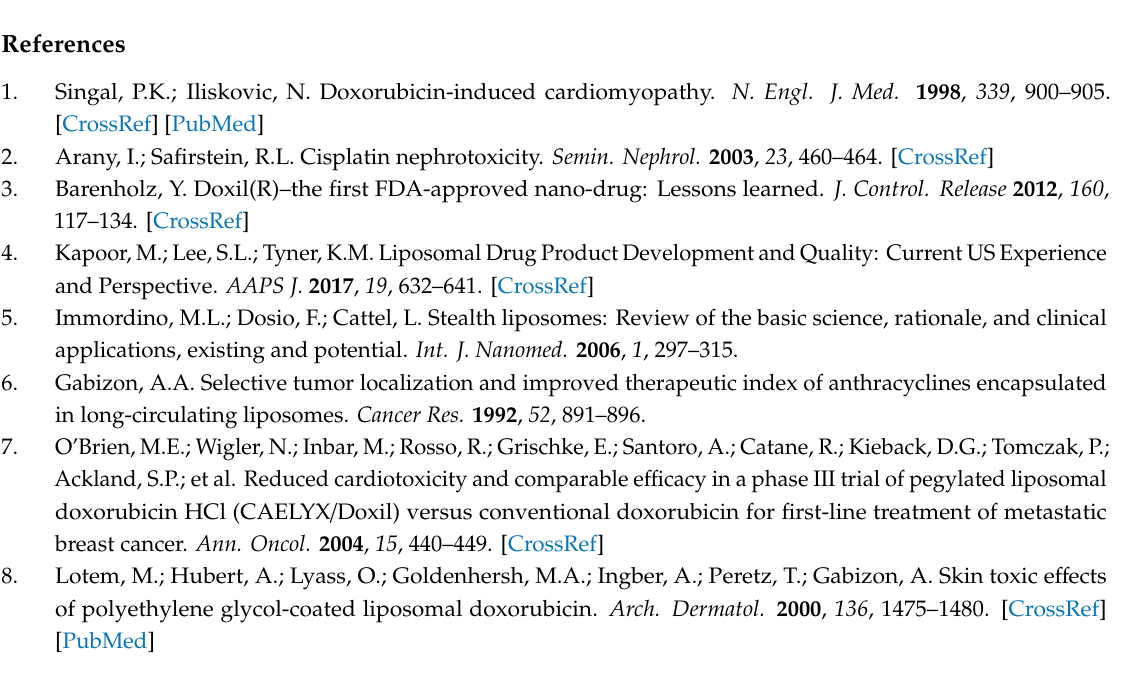
Figure S1: Therapeutical e ffi cacy of PL-Dox-Ce6 on nu / nu nude mice bearing human H460 human lung cancer cells, Figure S2: Release profile, alterations of particle size and polydispersities (PDI) of PL-cDDP-Ce6 after light irradiation, Figure S3: Therapeutical e ffi cacy of PL-cDDP-Ce6 on nu / nu nude mice bearing H460 tumors with average tumor size of 500 mm 3 before drug administration, Table S1: Biodistribution of Dox and Ce6 at di ff erent time points in BALB / c mice bearing syngeneic C26 tumor after intravenous injection of PL-Dox-Ce6, Table S2: Time course of Ce6 and Dox concentrations in di ff erent tissues of C26 tumor-bearing mice without or with light irradiation at 2 hr after intravenous injection of PL-Dox-Ce6, Table S3: Particle size and entrapment of PL-Ce6, PL-cDDP and PL-cDDP-Ce6, Table S4: Stability and particle size of PL-cDDP-Ce6 at 4 ◦ C, Table S5: Concentration of cDDP and Ce6 at di ff erent time points in BALB / c mice bearing syngeneic C26 tumor after intravenous injection of PL-cDDP-Ce6, Table S6: Time course of Ce6 and cDDP concentrations in di ff erent tissues of C26 tumor-bearing mice without or with light irradiation at 2 hr after intravenous injection of